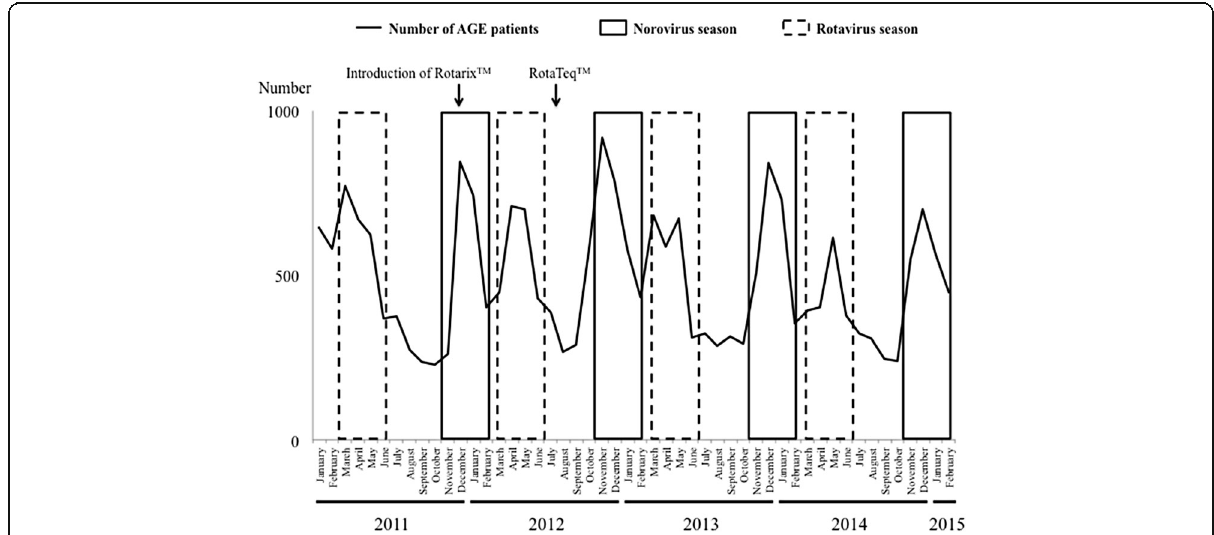
Fig. 1 Monthly numbers of AGE patients ≤ 15 years of age from January 1, 2011 to February 28, 2015. Black squares indicate the norovirus epidemic seasons. Dotted squares indicate rotavirus epidemic seasons. AGE, acute